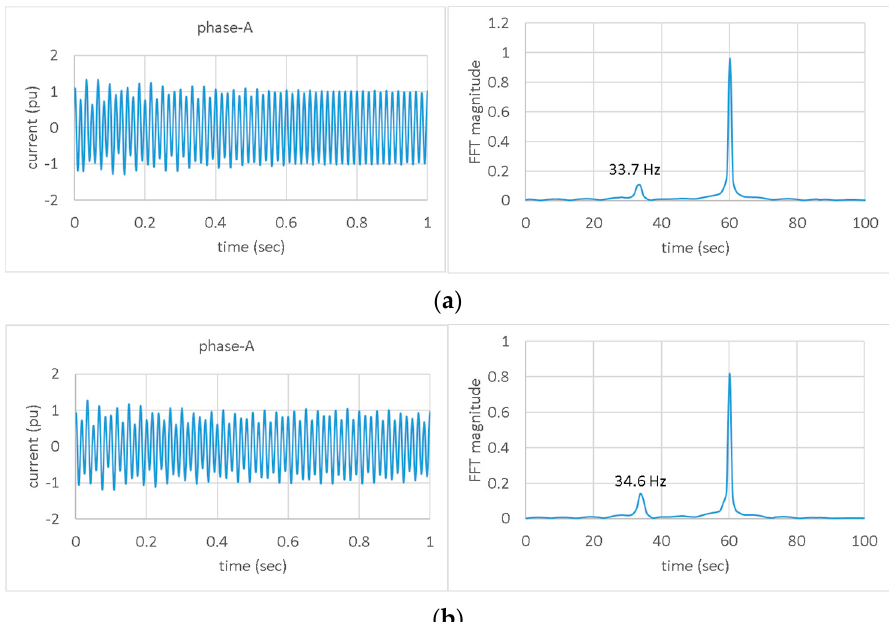
Figure 11. Generator current, ( a ) without and ( b ) with 100 MW DFIG wind farm.